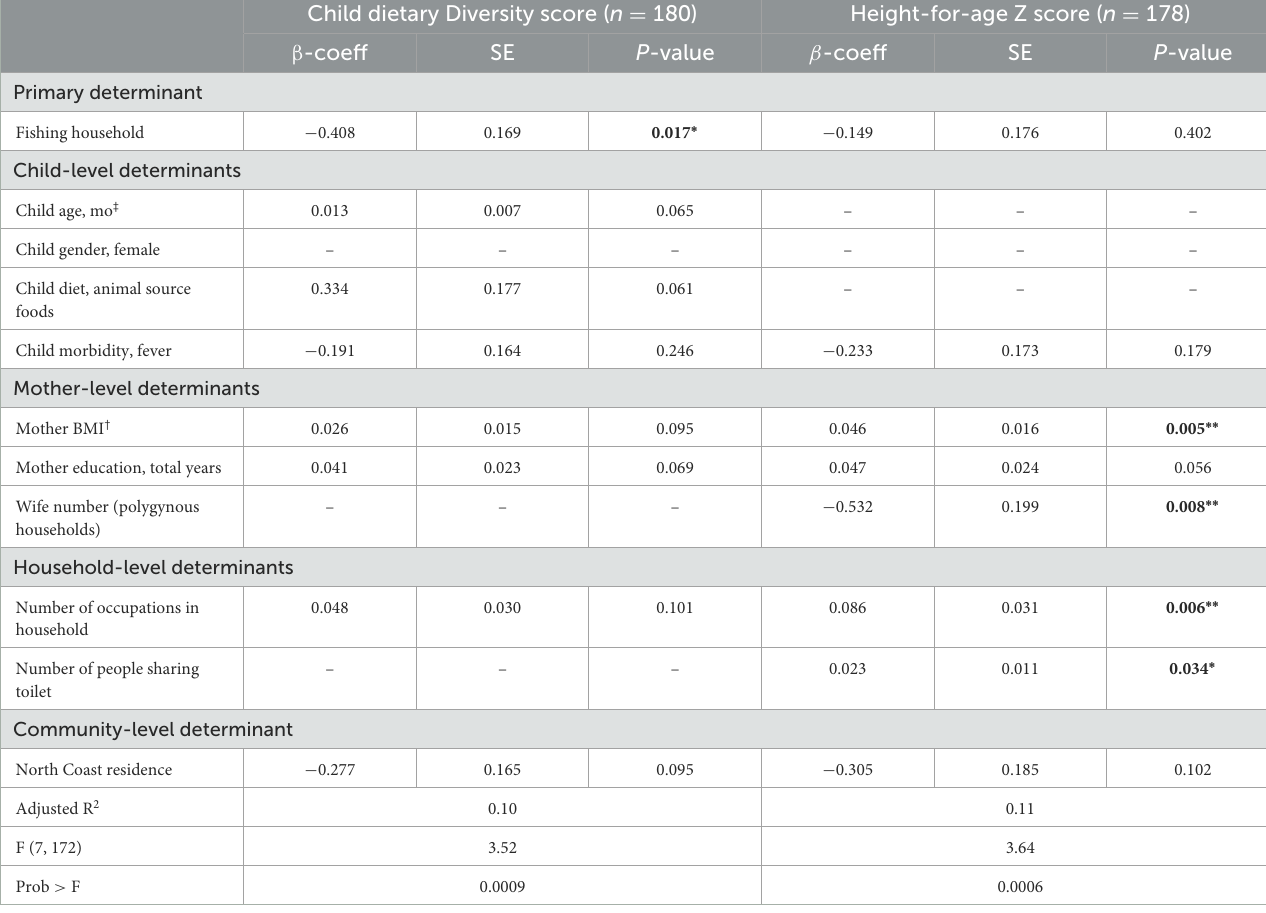
TABLE 4 Regression models for child dietary diversity score and height-for-age Z score. Child dietary Diversity score ( n = 180) Height-for-age Z score ( n = 178) β -coeff SE P -value β -coeff